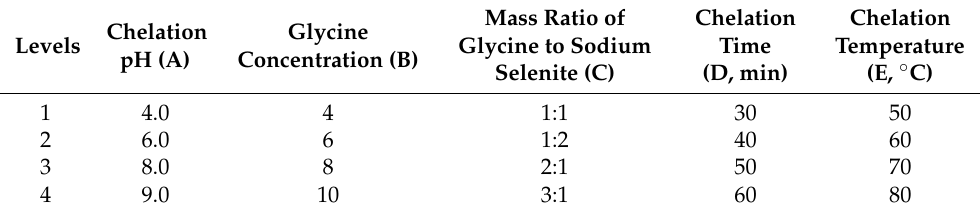
Table 4. Orthogonal experimental factor level values for Se − Gly